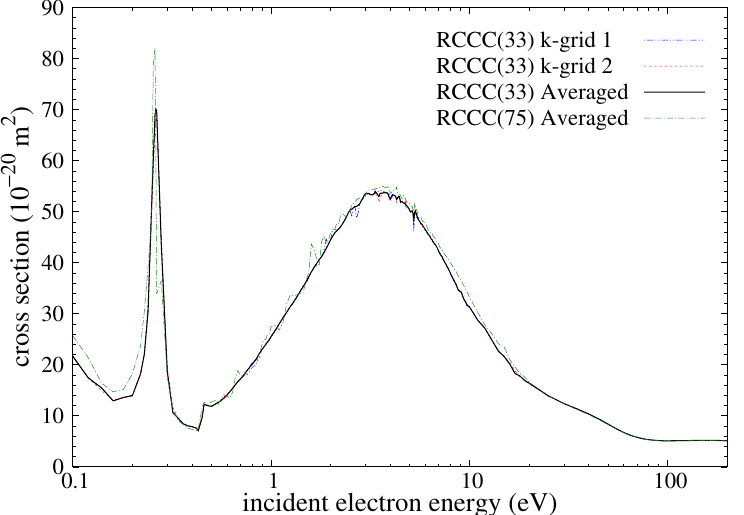
Figure 5. Numerical instability of the RCCC(33) model alongside the averaged results of RCCC(75). Shown for the elastic-scattering cross section for the ground